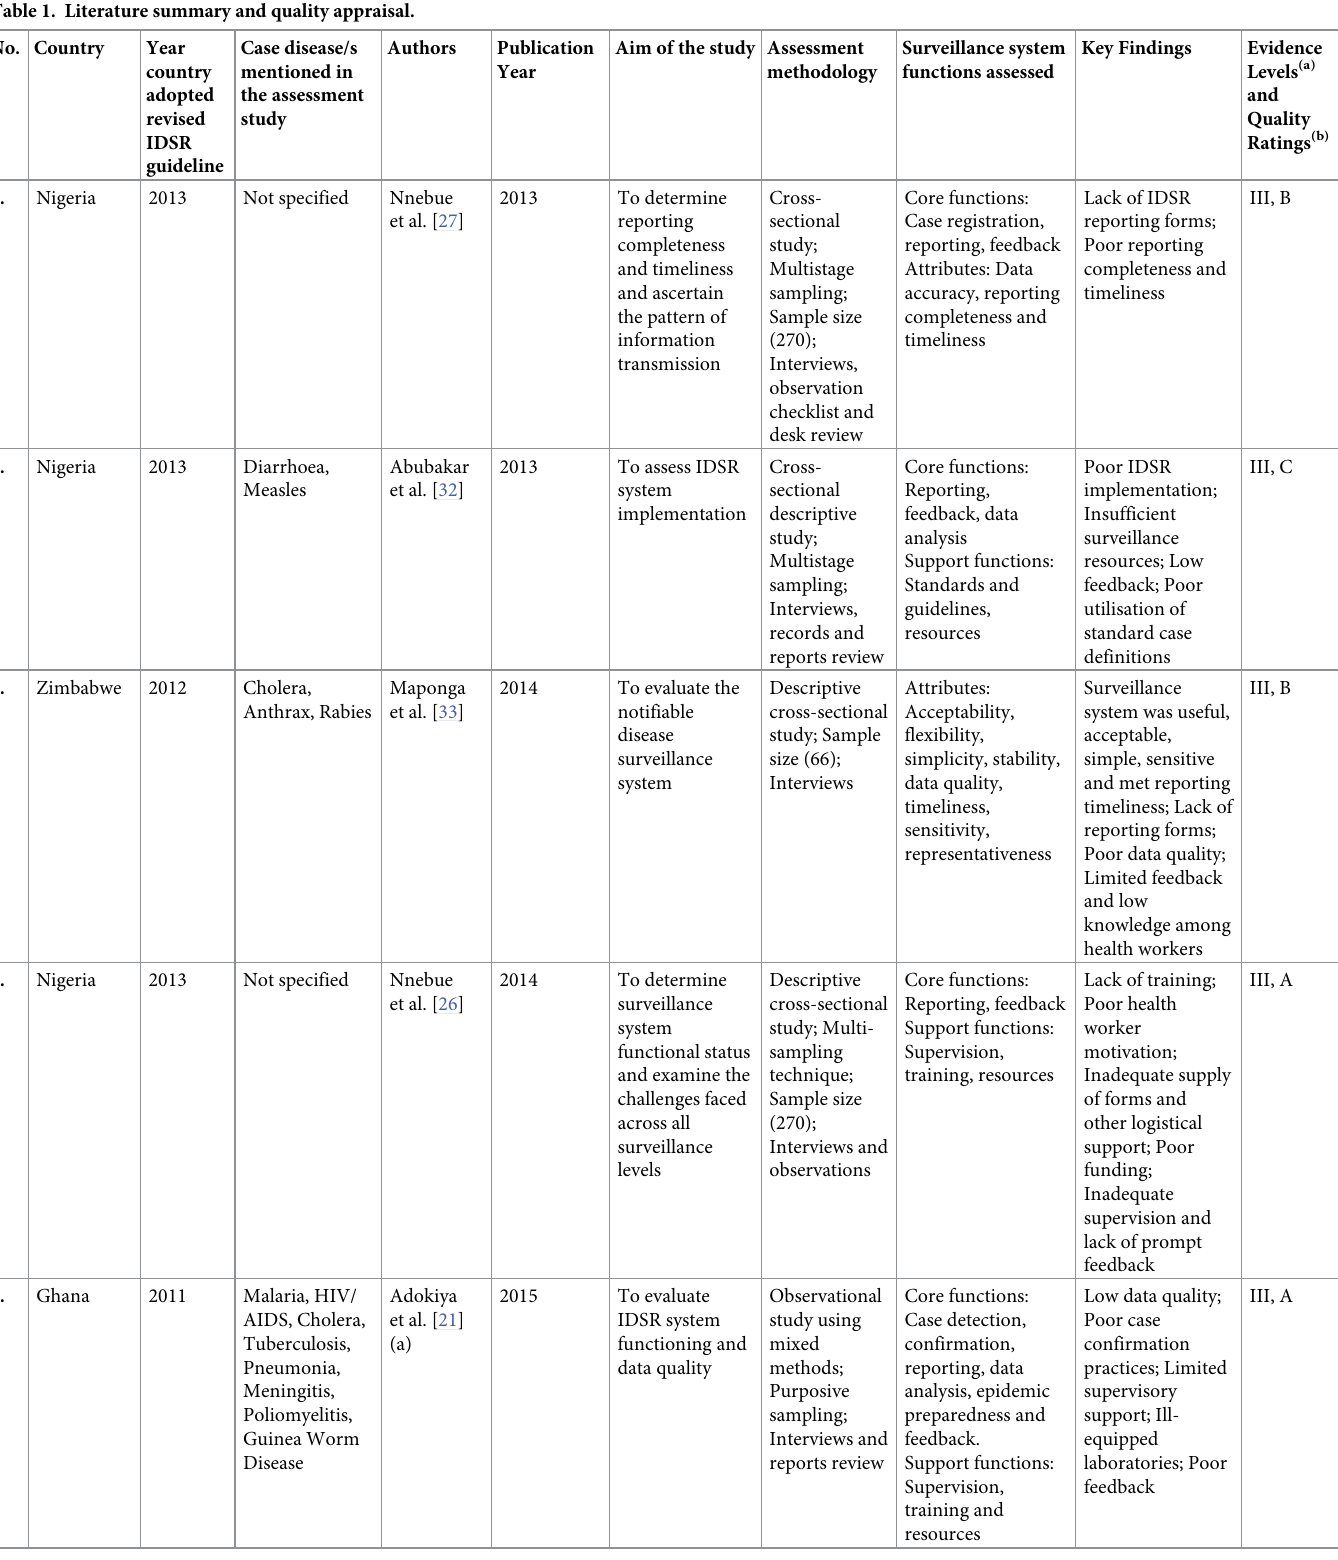
Table 1. Literature summary and quality appraisal. No.